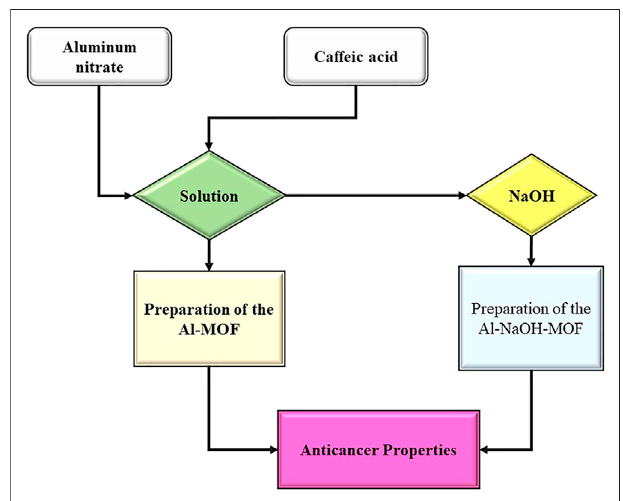
FIGURE1| The fl owchartoftheprocedureinvolvedinthepreparationof Al-MOF samples as an anticancer agent.